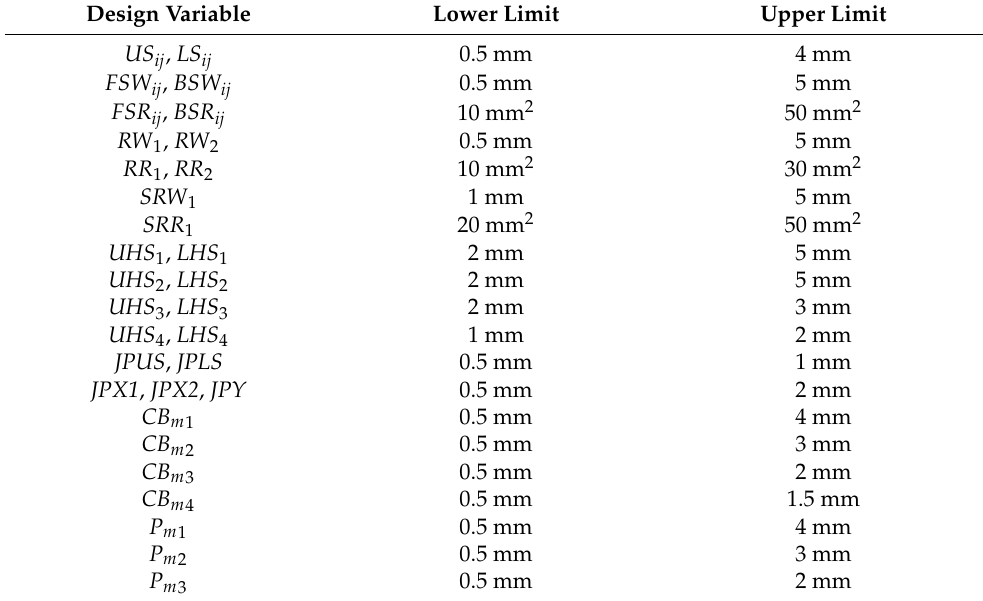
Table 3. Value range of each design variable.